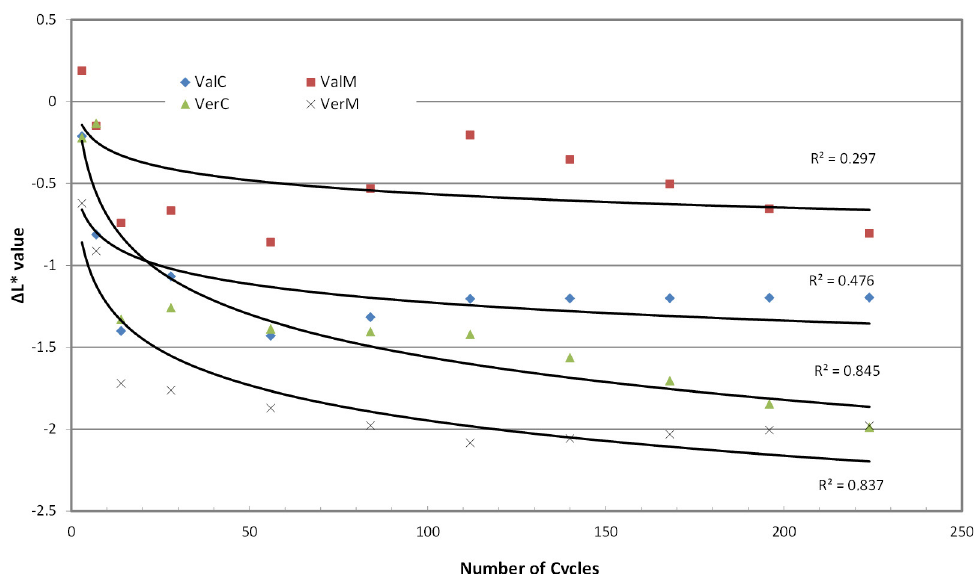
Figure 3- Trend lines for changes in ΔΕ* values